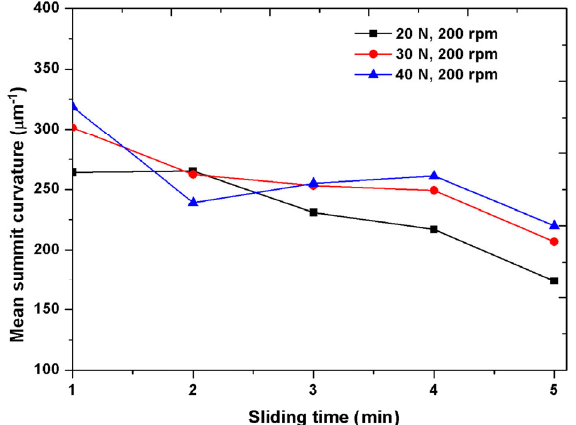
Fig. 19 Variation of S sc with sliding time for the same speed and different loads.